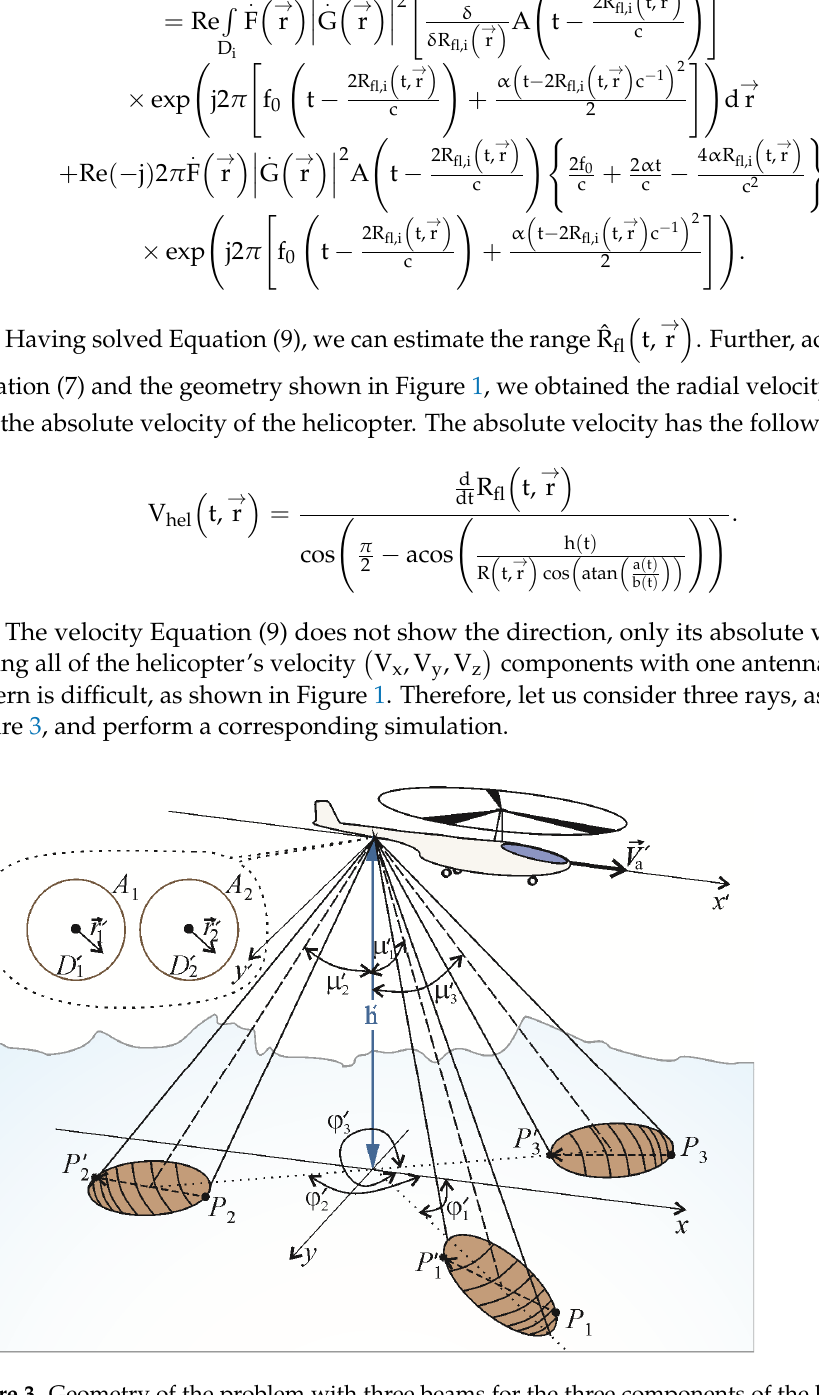
Figure 3. Geometry of the problem with three beams for the three components of the helicopter’s velocity vector and altitude.